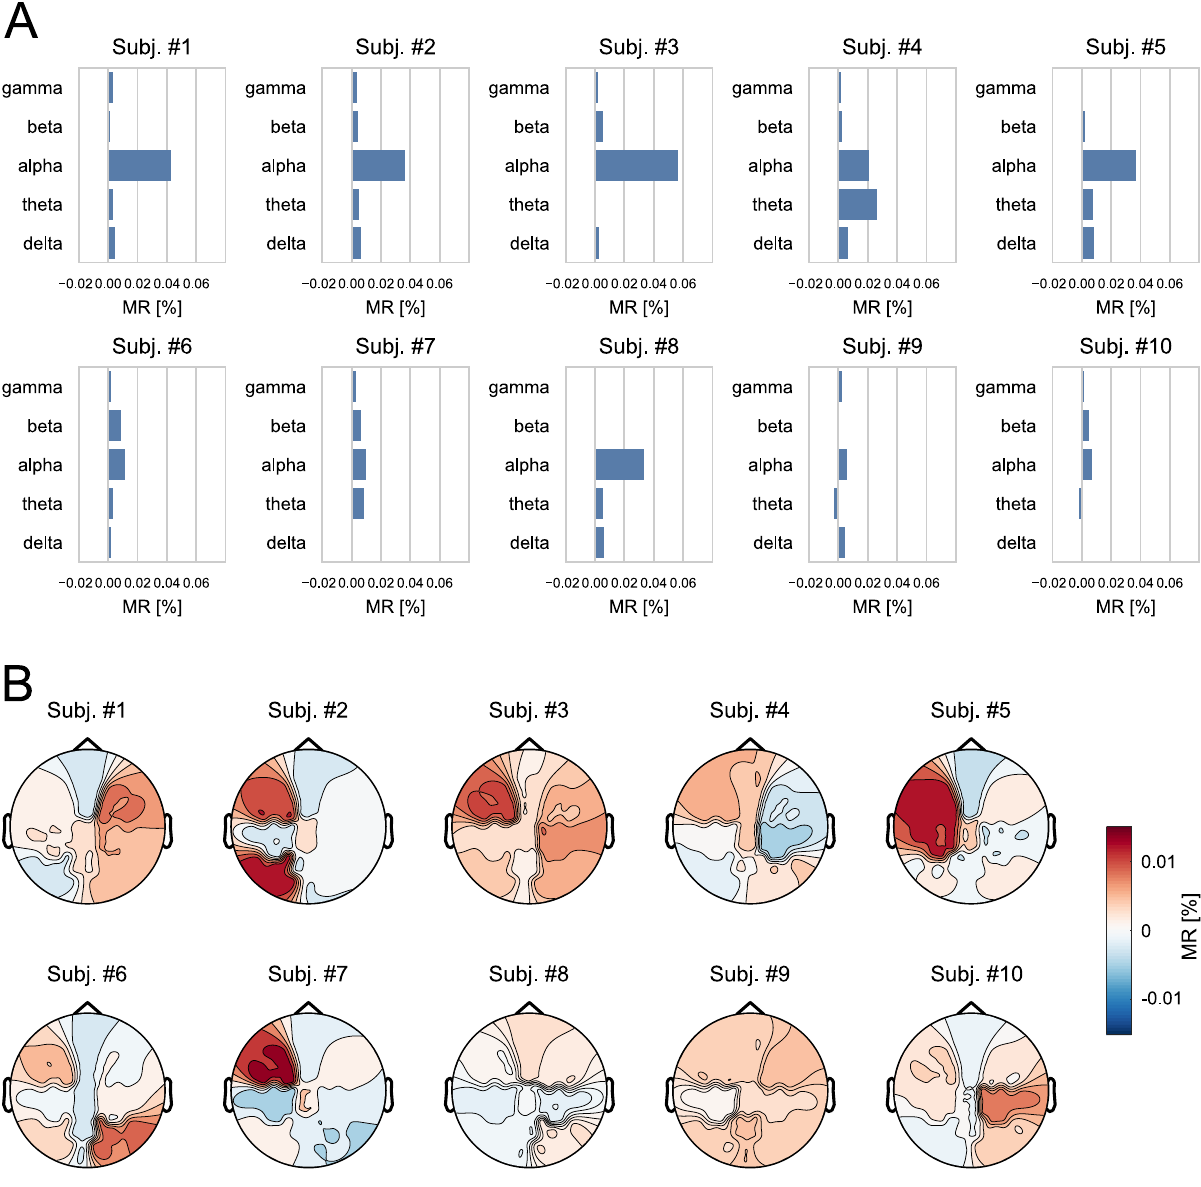
Fig 3. Grouped model reliances per subject. (A) Grouped model reliance scores (MR) on each frequency band for individual participants. (B) Topography of model reliances for individual participants.